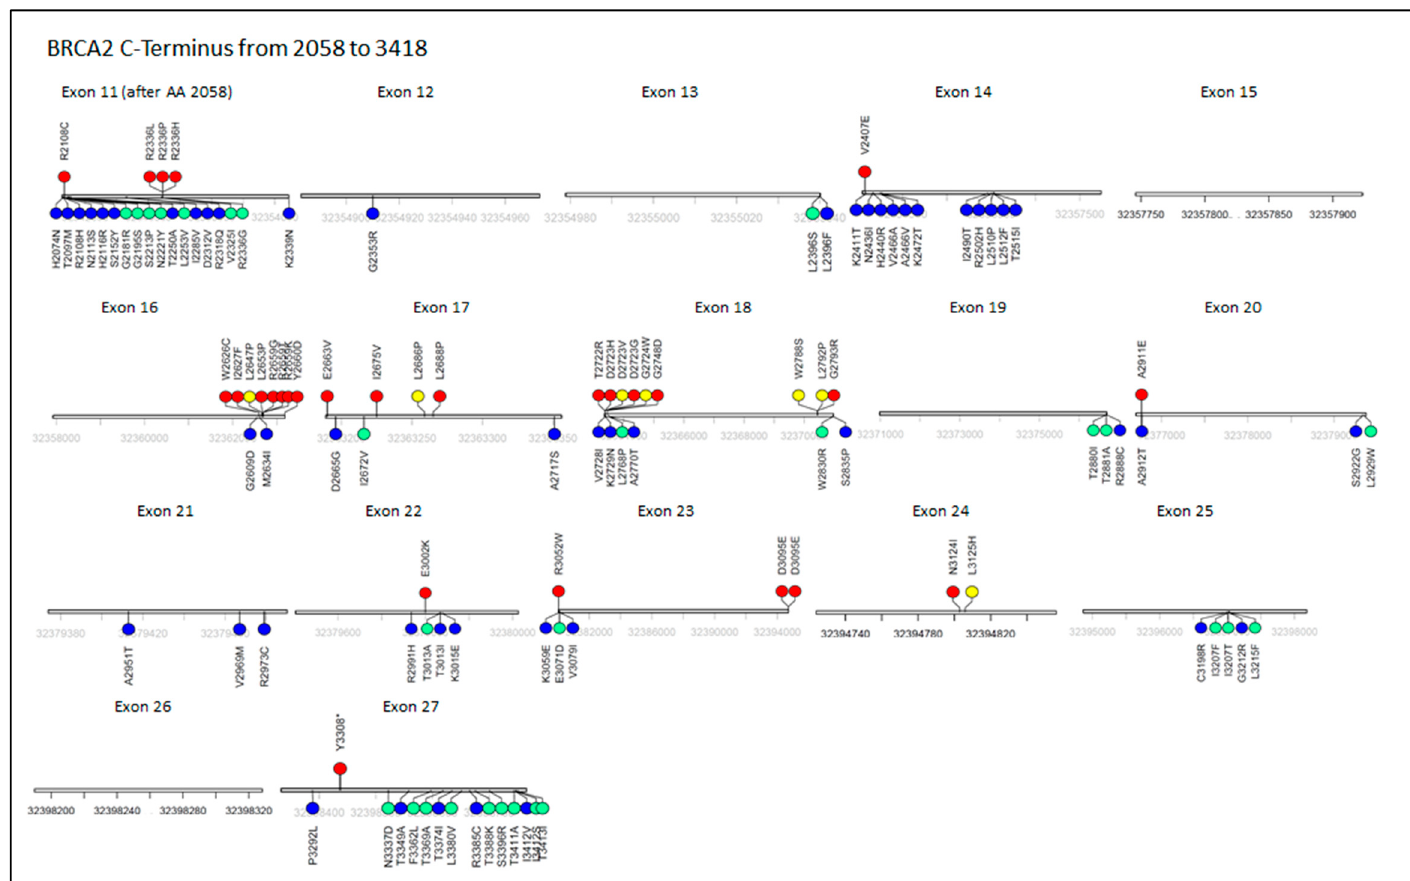
Figure 2. BRCA2 C-terminal variants: ClinVar data for missense mutations in the C-Terminus of BRCA2. Top: Red = Pathogenic, Yellow = Likely Pathogenic. Bottom: Green = Likely Benign, Blue: Benign. The most distal known pathogenic truncation is shown on Exon 27. Data on the pathogenicity of missense mutations can show hot and cold spots in the protein, guiding further inquiry and prioritizing some mutations for study. Over 4600 missense variants of unknown significance (VUS) exist in BRCA2 at the time of writing, with 1833 of those on the C-terminus (after the BRC repeats at Amino Acid 2058).